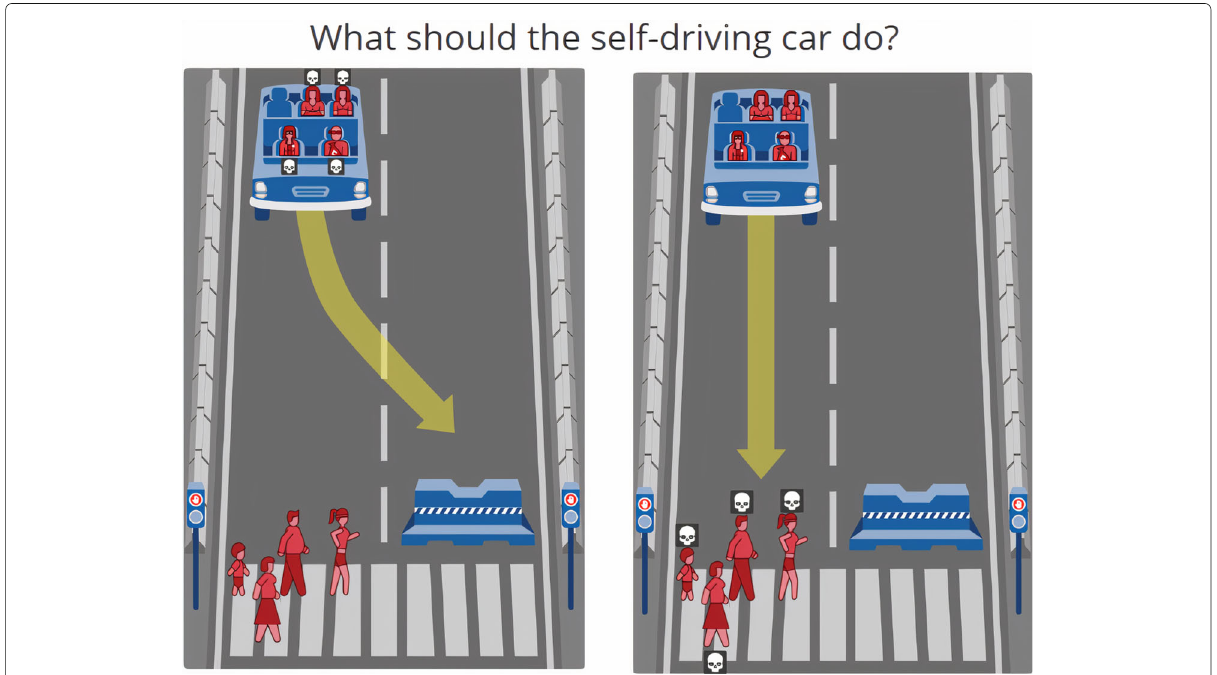
Fig. 1 Moral Machine Example: Example screenshot of a scenario from a Moral Machine scenario [8]. The participant must decide the more ethical course of action for the self-driving vehicle: swerving would kill all vehicle passengers (right), while maintaining the course would result in the death of all pedestrians (left)